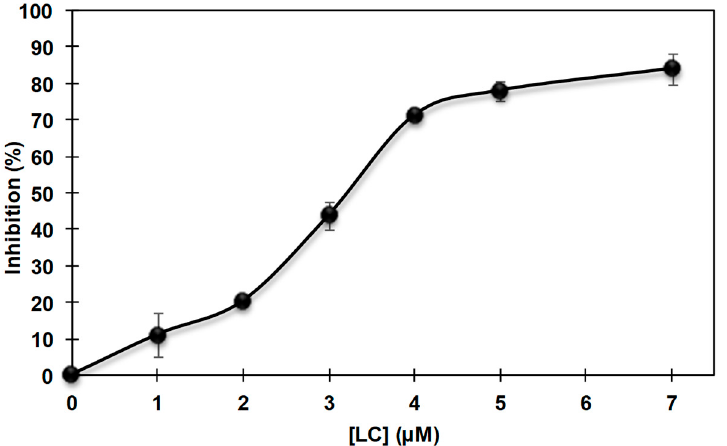
Figure 3. Percent of inhibition of mushroom tyrosinase activity vs. LC concentration using L ‐ DOPA (1 mM) as substrate. Reported are the mean ± SD values of at least three experiments.